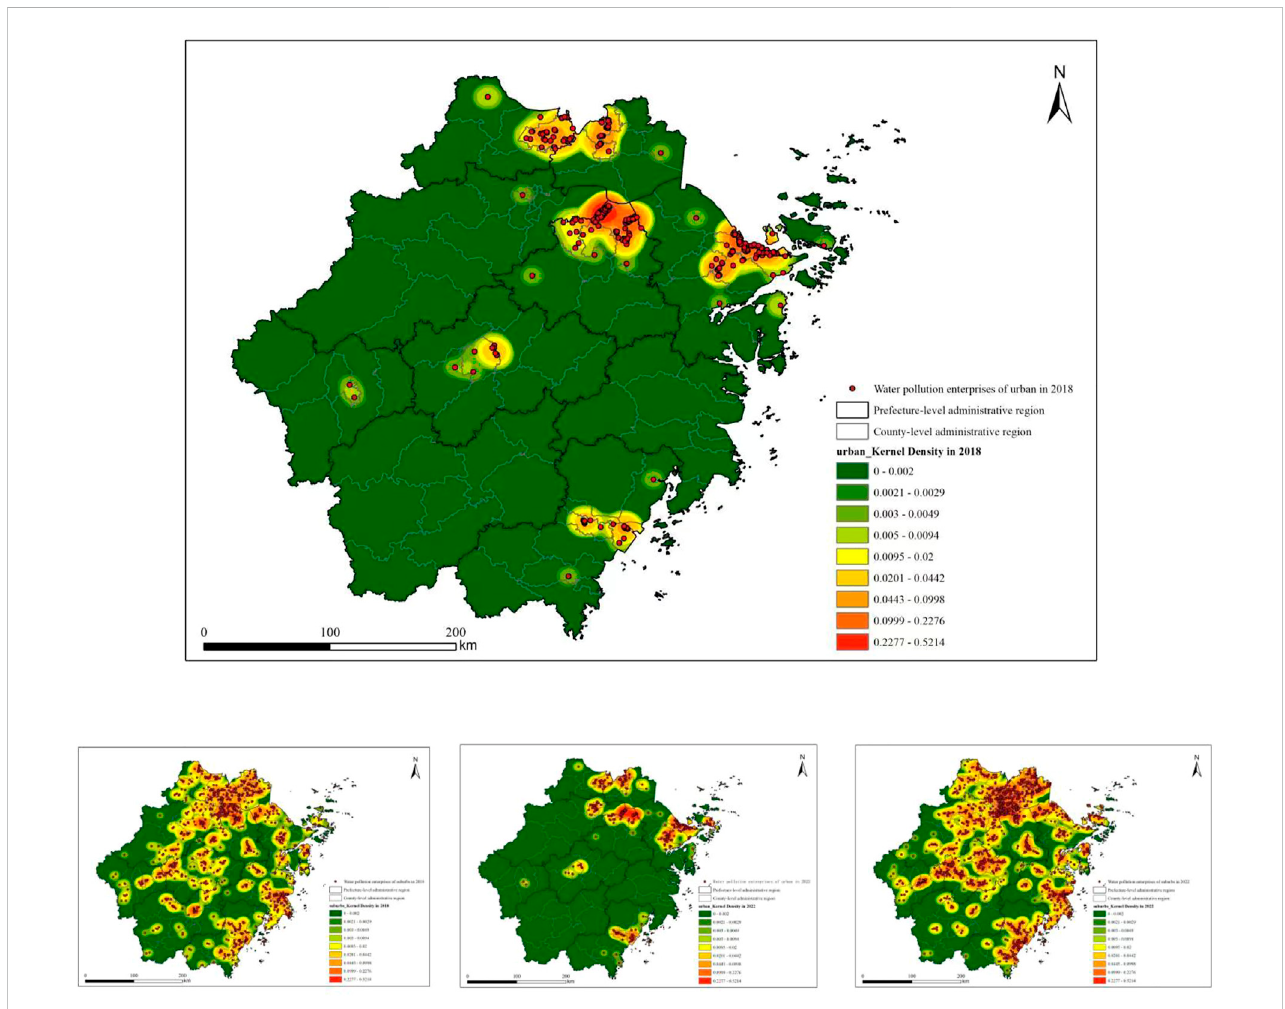
FIGURE 4 Estimation of Kernel density of water-polluting enterprises in urban and suburban areas in Zhejiang Province in 2018 and 2022.